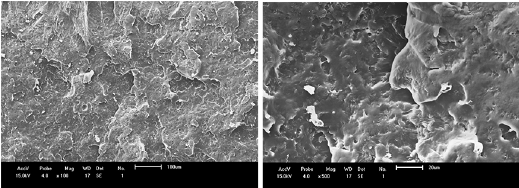
Figure 12: SEM image of fractured surface of PCL. (Scale bar: 100 μm and 20 μm).